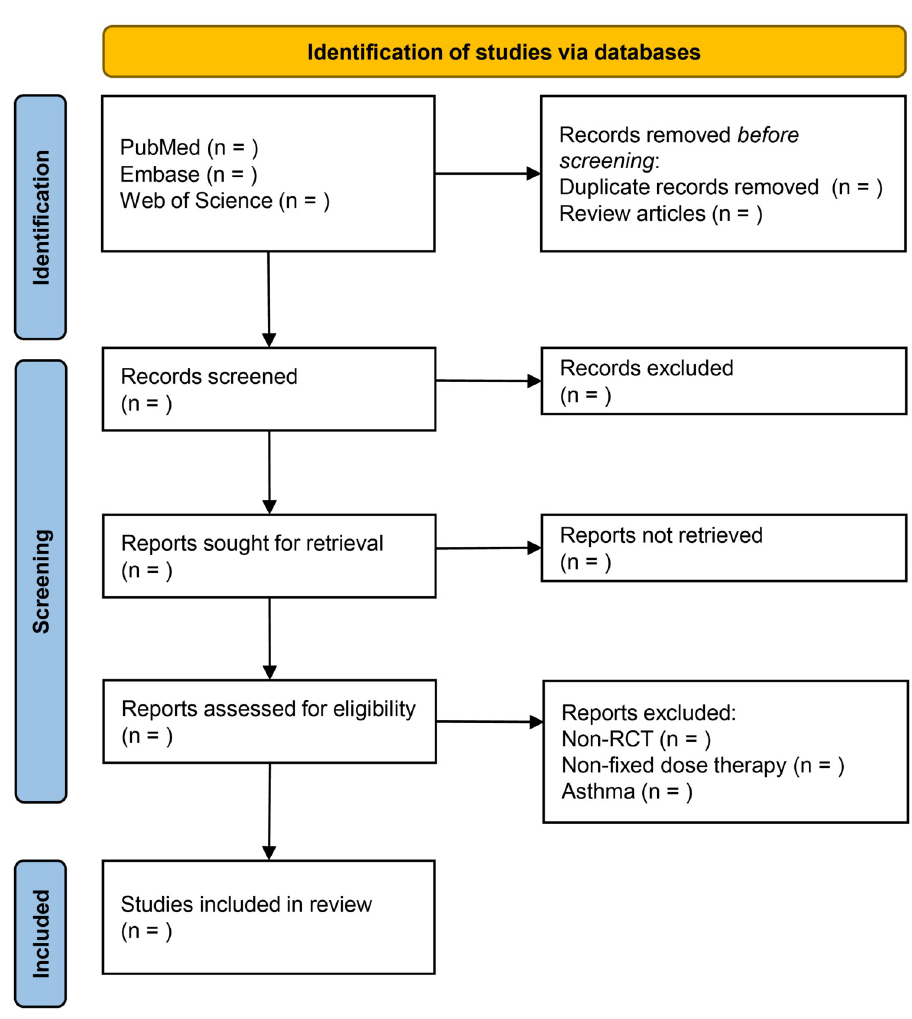
Fig 1. Flow chart of the study selection. RCT, randomised controlled trial.